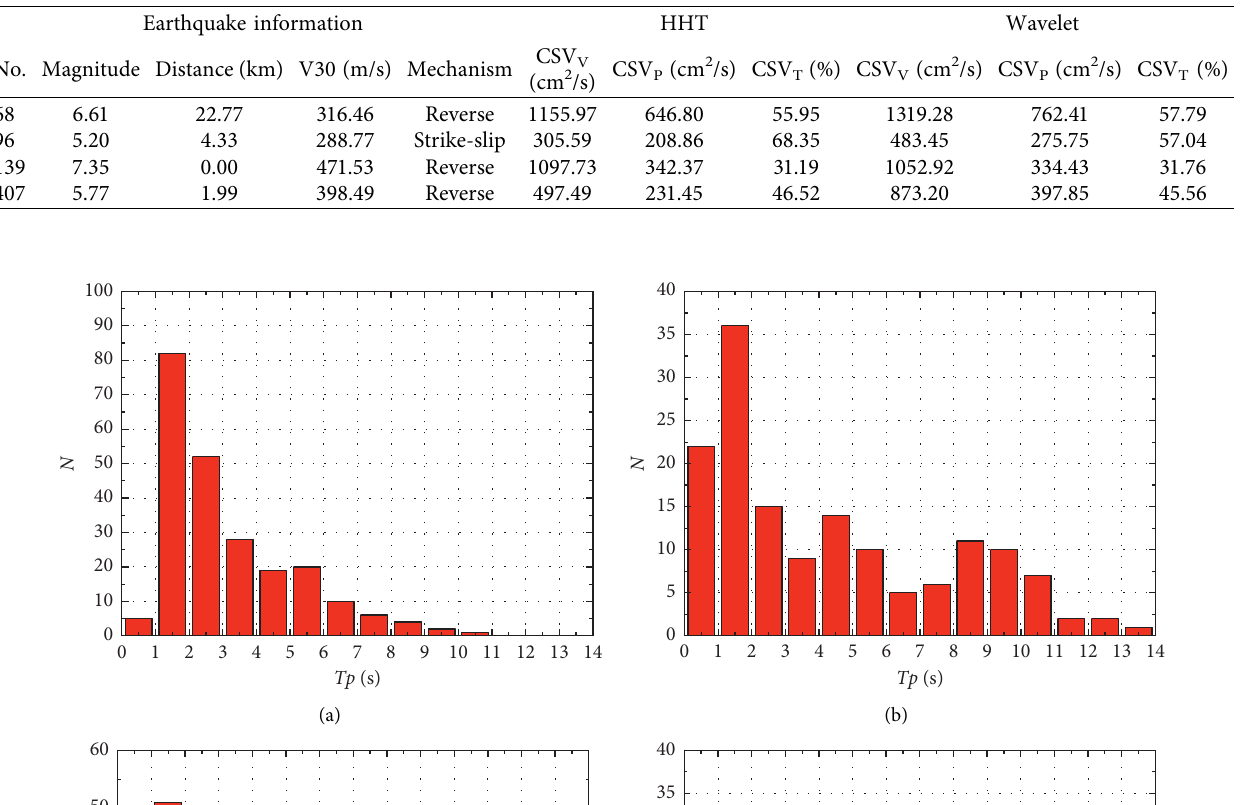
Table 6: The CSV table.